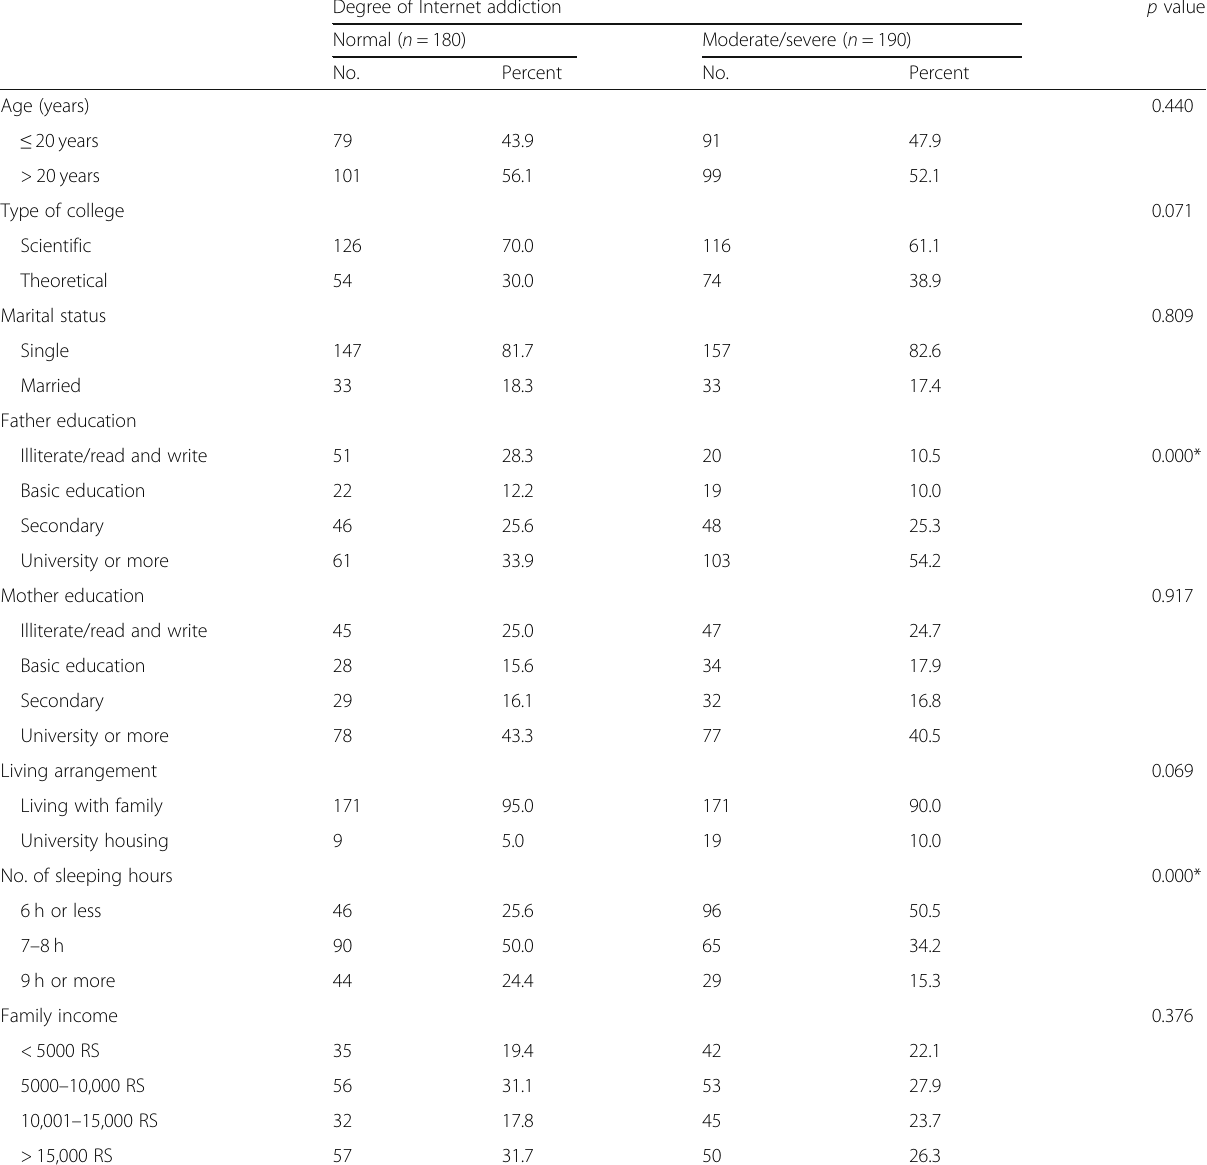
Table 3 Relationship between Internet addiction and sociodemographic features of female students at Jouf University, SA,